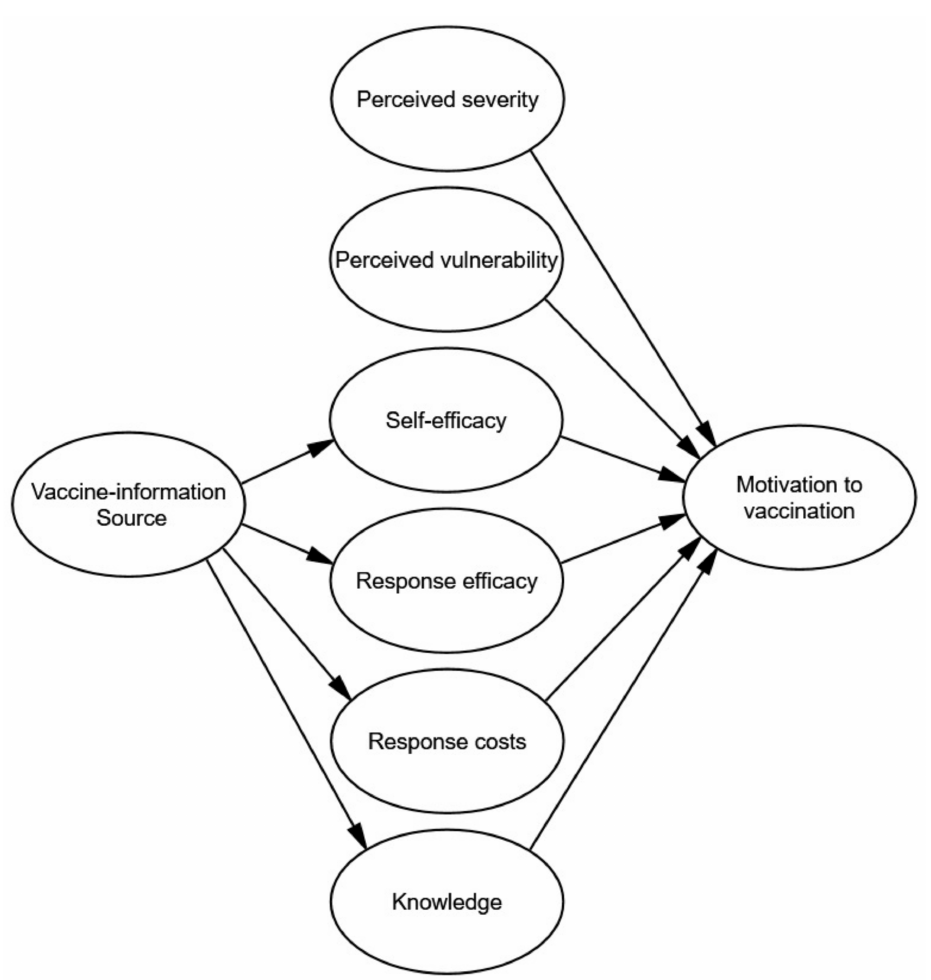
Figure 1. Hypothetic